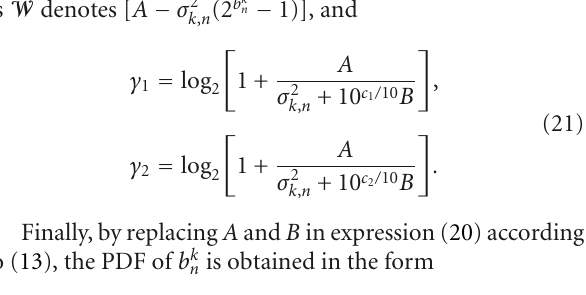
Figure 3: Histogram of the measured FEXT channel attenuation | h k | 2 for an ordinary 500 m long 26 AWG cable of 20 twisted pairs n , m and assuming downstream ADSL2+ frequency